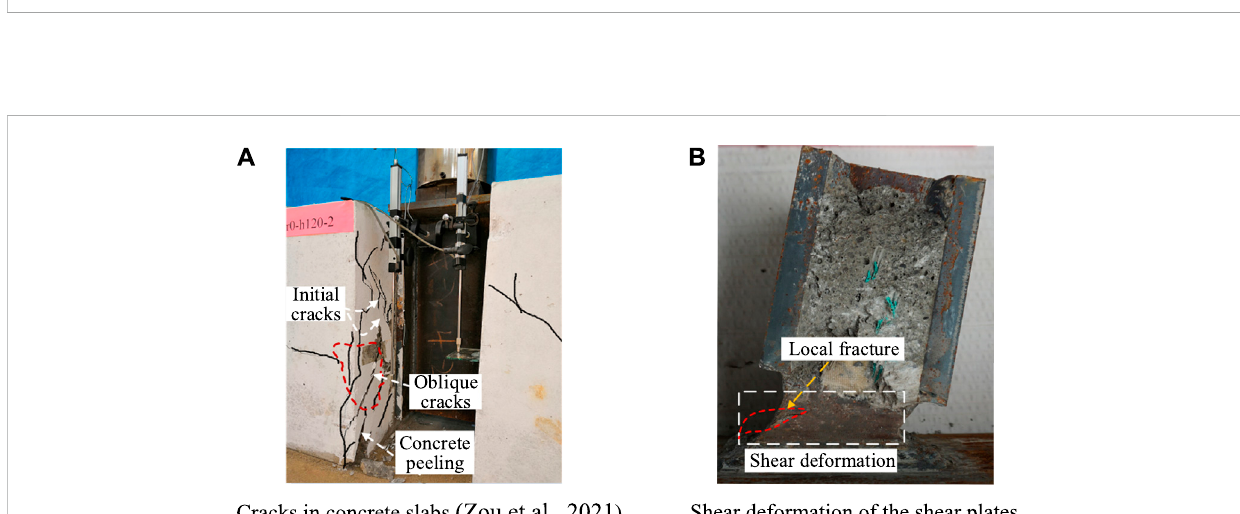
3 specimens of each group were cyclically loaded. The detailed loading protocol can be referred to the previous push-out tests (Zou et al.,